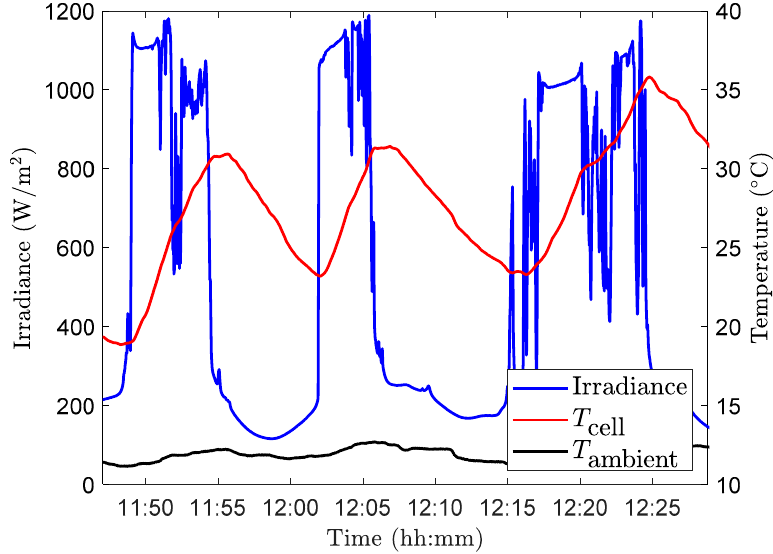
Figure 10. An example of irradiance, and ambient and PV cell temperatures during a partly cloudy period.